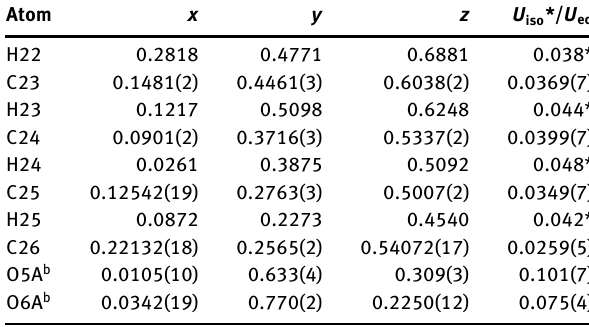
Table 2: Fractional atomic coordinates and isotropic or equivalent isotropic displacement parameters (Å 2